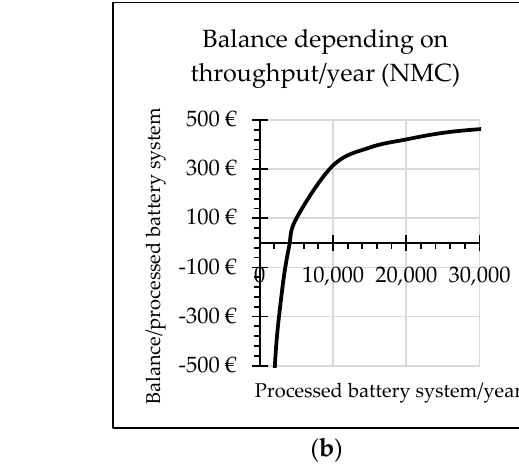
Figure 15. Sensitivity analysis: influence of throughput per year of retired EVs on the cost – benefit- balance for ( a ) LFP cathodes and ( b ) NMC cathodes.